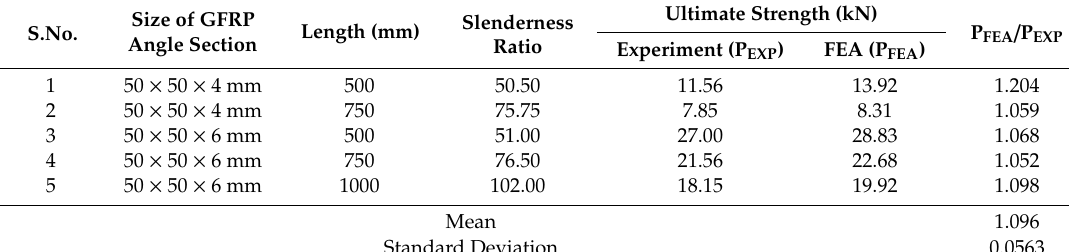
Table 3. Ultimate strength of GFRP angle sections .